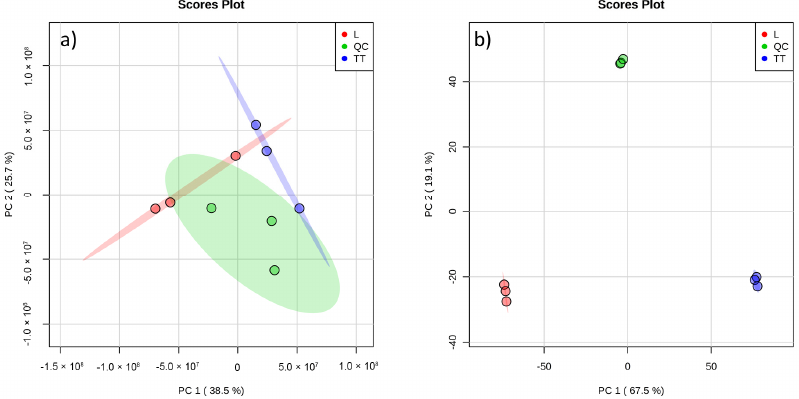
Figure 2. A comparison of pre-processing protocols in group-based analysis. ( a ) Principal component analysis (PCA) of mean-centered analytes; ( b ) PCA of mean-centered and log-transformed analytes. The shaded regions represent the 95% confidence interval the individual